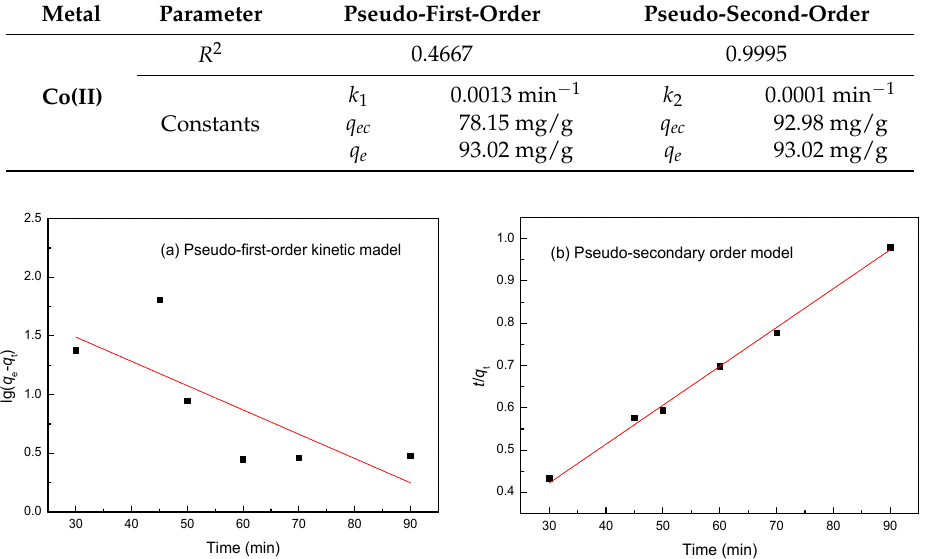
Table 2. Kinetic parameters for Co(II) adsorption onto LMT.